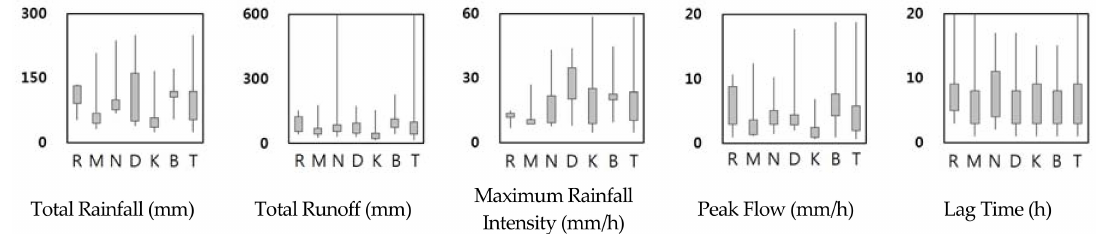
Figure 2. Box plot of the flood characteristics of the 113 flood events (Boxes are 25% and 75% quantiles,